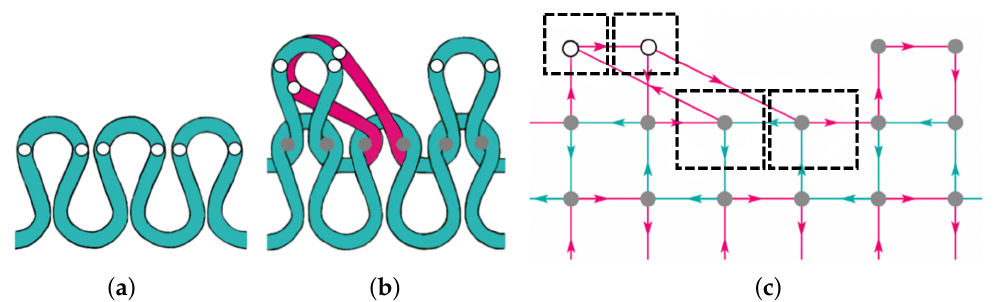
Figure 4. A Front Transfer stitch is created when the loop of a Knit stitch is transferred up to three needle positions away to the left or right. ( a ) Row of loops. ( b ) Two Knit stitches and a Front Transfer stitch produced from another row of stitches. ( c ) Topological representation.